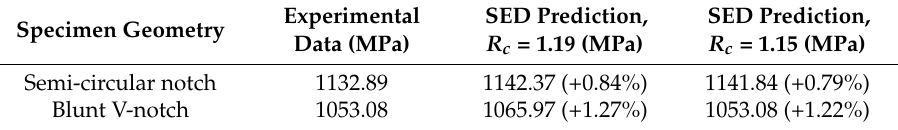
Table 4. Comparison in the SED tensile failure assessment using the critical radius obtained according to the procedure described in Ref. [7] (“SED prediction, R c = 1.15”) or leveraging on the fracture toughness value from literature (“SED prediction, R c =